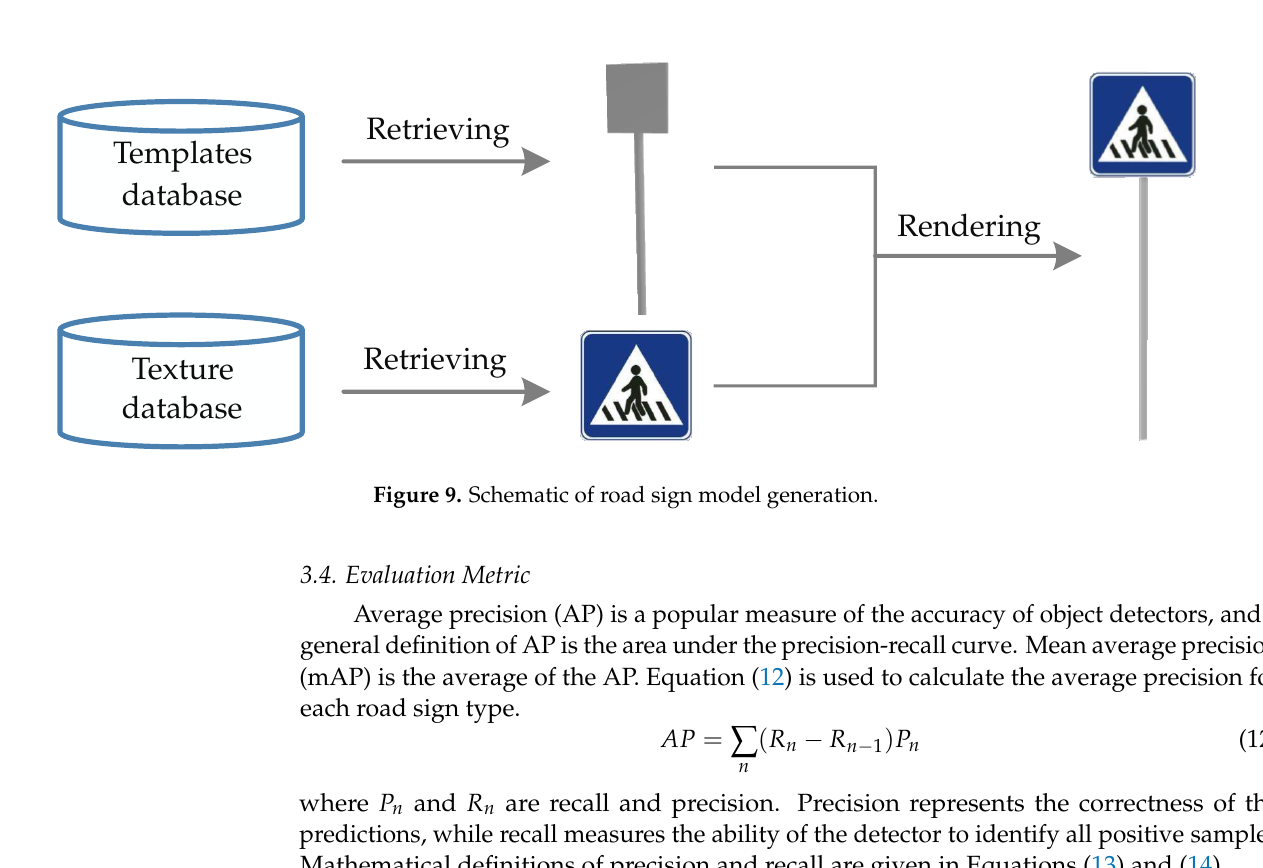
Figure 8. 3D templates and texture database of road signs. On the basis of the classification and 3D bounding box results, the correspondence template and texture are retrieved from the database to generate a rendered road sign model, and the template with the size closest to the generated 3D bounding box is selected.